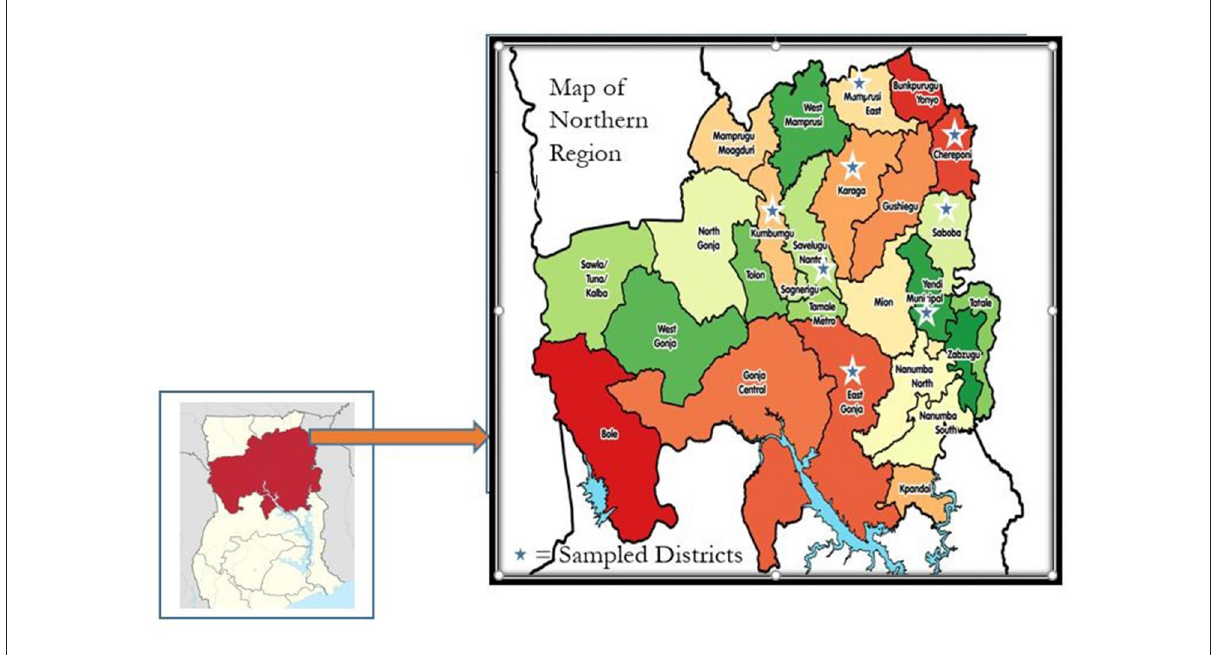
FIGURE1 The map of study